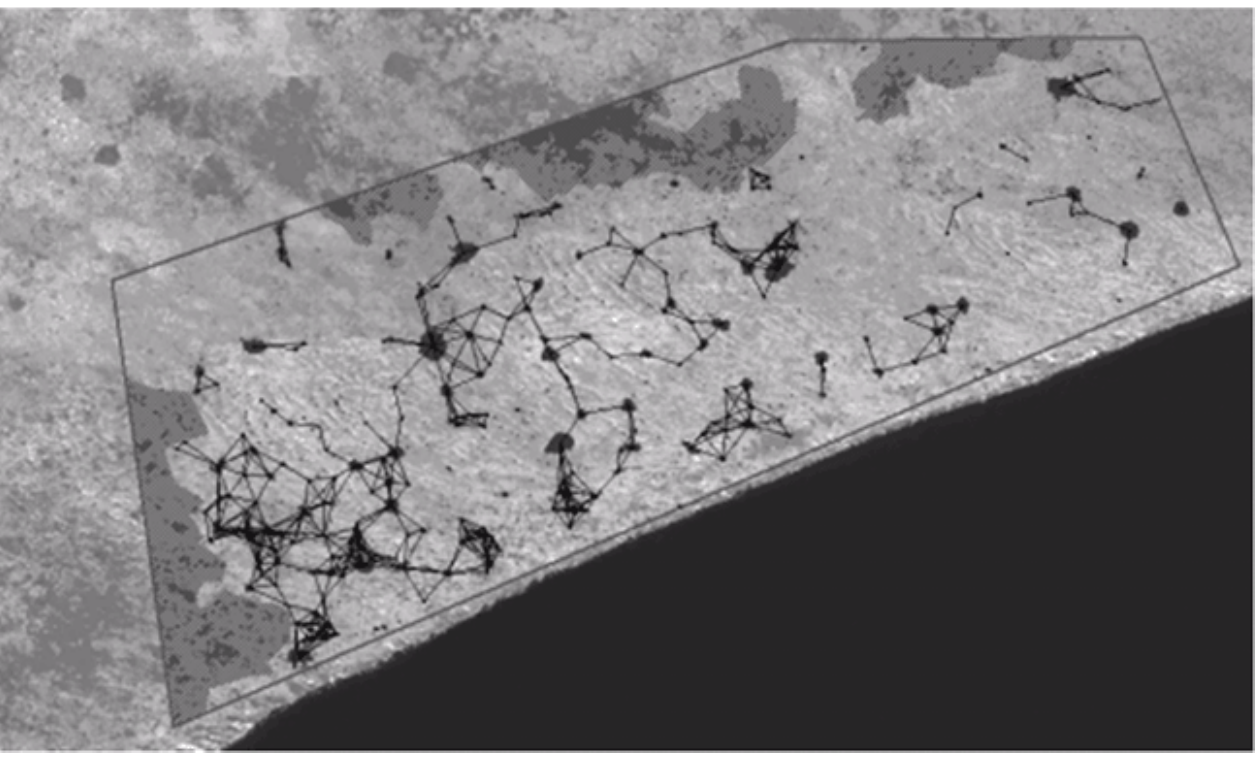
Fig. 4 . Southern Androy, Madagascar, as seen in a Landsat image from May 2000 (adapted from Bodin et al. 2005). The study area is defined by the rectangular box. The isolated forest patches are distinguished by the separate dark spots situated within the light gray matrix of cultivated land. Patch sizes range from 1 to 95 ha, and the patches are fairly evenly distributed in the landscape. Areas classified as source areas are marked in the western and northern parts of the studied area. The spatial structure of connectivity of the present landscape, including forest patches measuring 1 ha or larger, as expressed through the graph theoretical model is shown when the vagility of Lemur catta is set to 1000